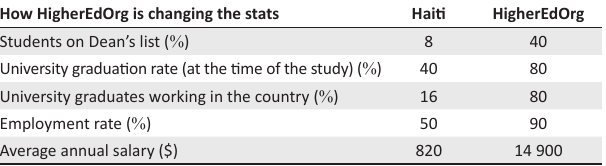
TABLE 1: HigherEdOrg